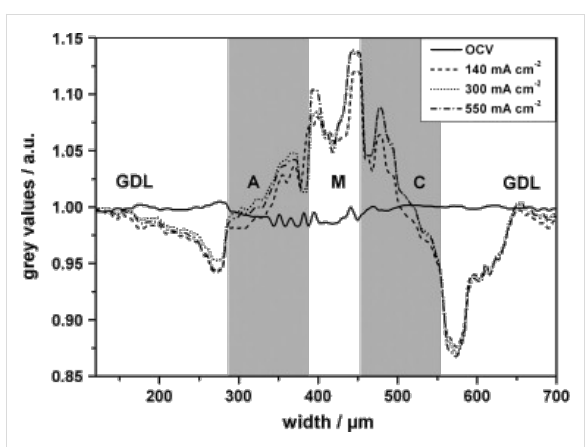
Figure 15: Changes of the transmission through the MEA (grey values) compared to steady-state conditions at OCV for different oper- ating conditions: at OCV (solid line), 140 mA·cm − 2 (dashed line), 300 mA·cm − 2 (dotted line) and 550 mA·cm − 2 (dot and dash line). Reprinted with permission from [65]. Copyright 2010